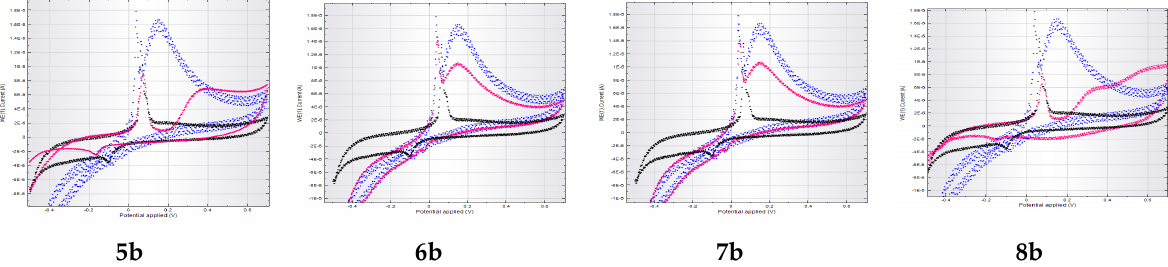
Figure A6. Overlapped CVs for the oxidation signal obtained for 0.5 mM H 2 O 2 in the absence (blue) and in the presence 0.5 mM of the novel synthesized compounds (pink) prepared in 0.1 M KCl on Au SPE. Black line: CV recorded in 0.1 M KCl.